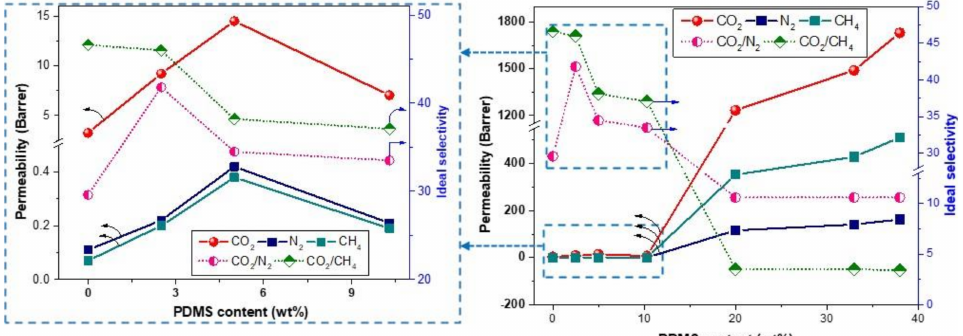
Figure 7. Gas permeability of copolymer membranes with various loadings of PDMS, inset ( left side ) is the original plot ( right side ) at low content of PDMS up to 10 wt %